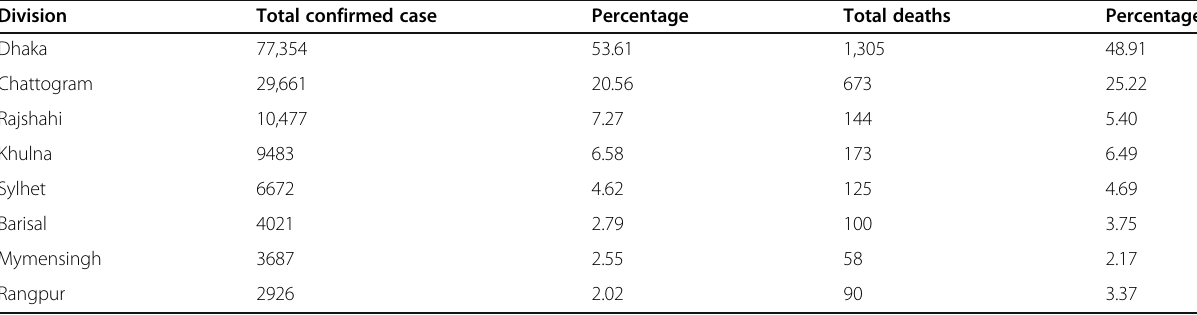
Table 1 COVID-19 confirmed cases in Bangladesh (up to 20 July 2020)